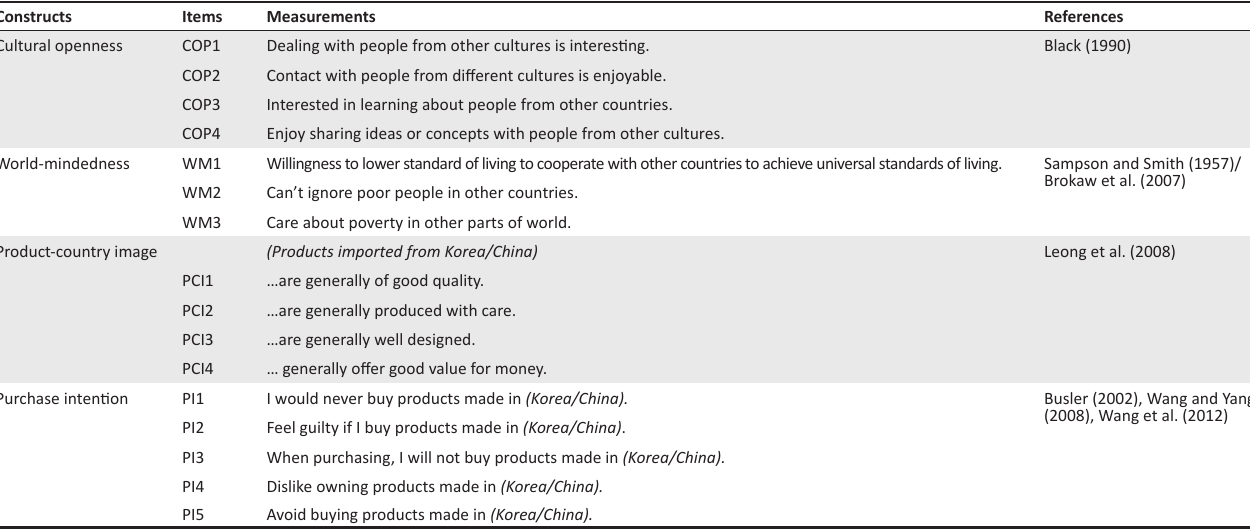
TABLE 2: Constructs and measurement items. Constructs